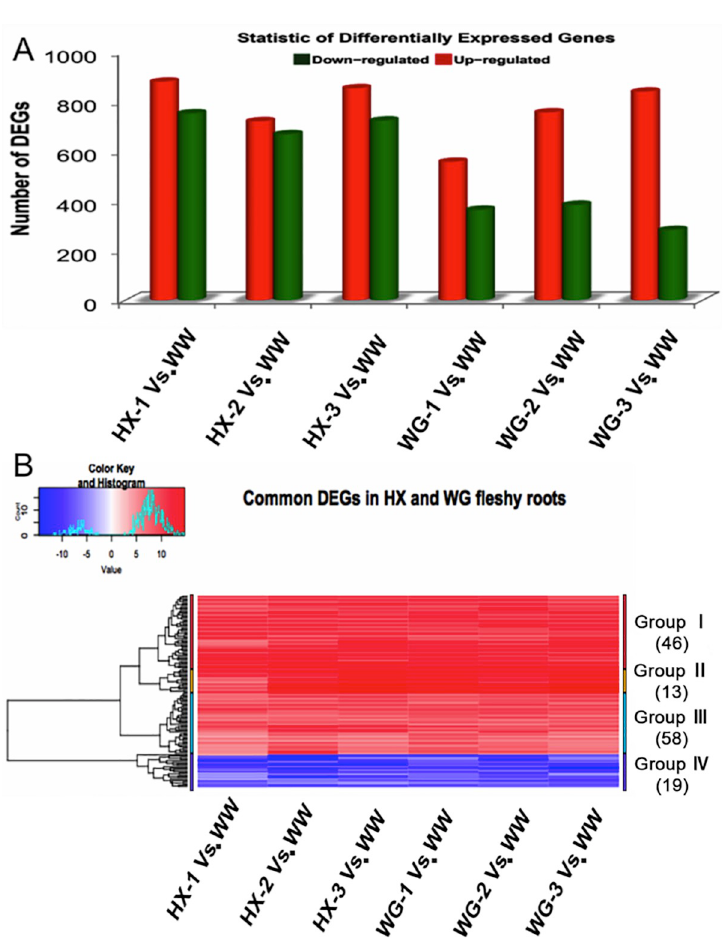
Fig 2. Transcriptional changes of anthocyanin synthesis-related genes in radish variant. (A) Statistics of differentially expressed genes (including up-regulated and down-regulated genes in each comparison groups) in seven radish color variants by performing pair-wise comparisons of the two radish cultivars ‘HX-1’ and ‘WG-1’, as well as their elite inbred lines ‘HX-2’, ‘HX-3’ and ‘WG-2’, ‘WG-3’. For each radish phenotype, comparison of changes in gene expression between NM_WW group and colored radish variant (‘HX-1’ and ‘WG-1’, as well as their elite inbred lines ‘HX-2’, ‘HX-3’ and ‘WG-2’, ‘WG-3’) was conducted. (B) Clustering and heat map of common differentially expressed genes (co-modulated genes) based on the expression profiles of the two radish cultivars ‘HX-1’ and ‘WG-1’, as well as their elite inbred lines ‘HX-2’, ‘HX-3’ and ‘WG-2’, ‘WG-3’.